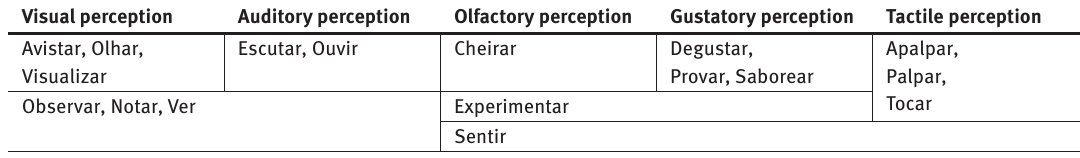
Table 2. The semantic distribution of perception verbs in Brazilian Portuguese Visual